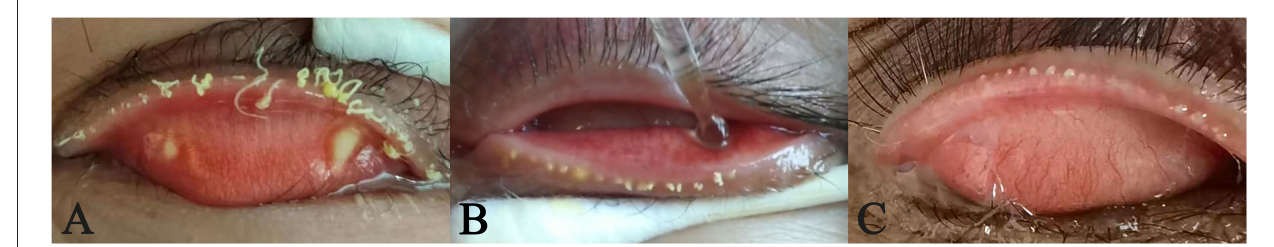
FIGURE 1 | (A) Solid meibum and yellow oil embolism. (B) Solid meibum. (C) Oily liquid